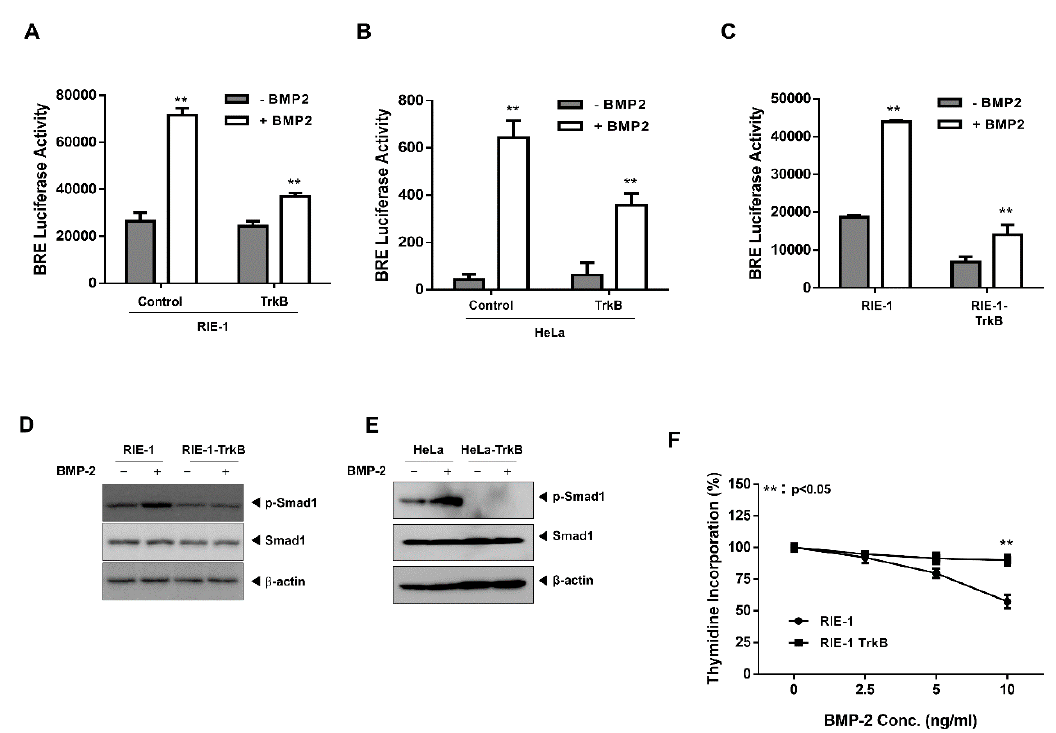
Figure 1. Tropomyosin receptor type B (TrkB) overexpression inhibited the tumor-suppressive activities of bone morphogenetic protein (BMP)-2. ( A , B ) BMP-2-responsive BMP response element (BRE) Luciferase reporter activity in rat intestinal epithelial cells (RIE-1). ( A ) and HeLa cells ( B ) transfected with the TrkB construct. Luciferase activity was measured 24 h after treatment with BMP-2 (5 ng / mL). ** Control versus treatment with BMP-2, p < 0.05, n = 3. ( C ) BMP-2-responsive BRE Luciferase reporter activity in RIE-1 and RIE-1-TrkB cells. ** Control versus treatment with BMP-2, p < 0.05, n = 3. ( D , E ) Western blot analysis of phospho- SMAD family member 1 (SMAD1) and SMAD1 expression in RIE-1 or RIE-1-TrkB cells ( D ), or in HeLa or HeLa-TrkB cells ( E ) after stimulation with BMP-2 (5 ng / mL). ( F ) Thymidine incorporation assay of RIE-1 and RIE-1-TrkB cell proliferation following treatment with various BMP-2 concentrations. The points represent the means from three measurements ± SD. ** RIE-1 versus RIE-1-TrkB, p < 0.05, n = 3. * RIE-1 versus RIE-1-TrkB, p < 0.03, n =